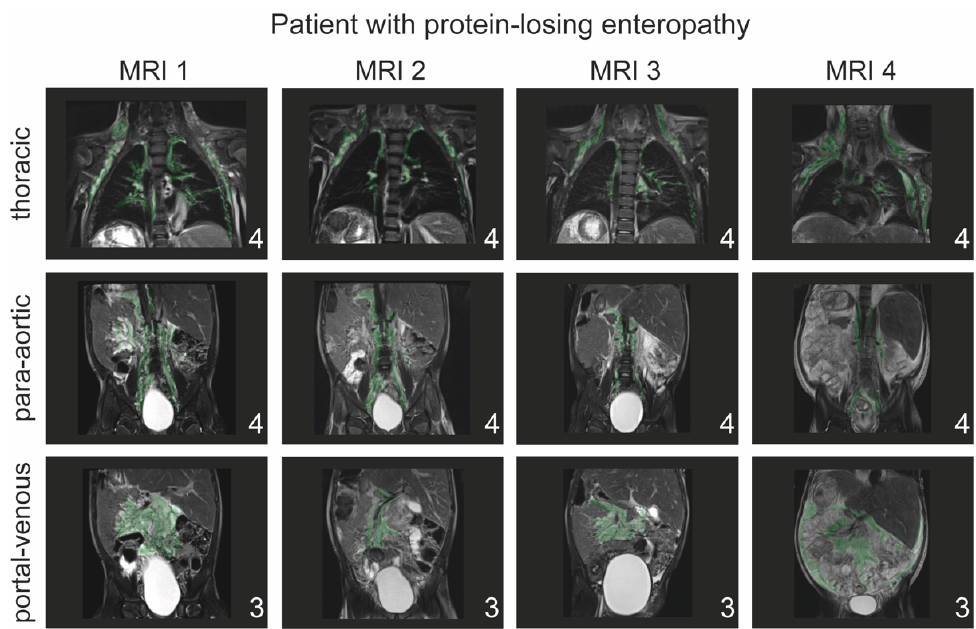
Figure 5. Example of patient with protein-losing enteropathy. Patient who presented with pro- longed pleural effusion (28 days) and edema after TCPC requiring diuretic therapy. Over the next two years, the patient presented with continuous clinical deterioration requiring frequent admis- sions to hospital for volume overload, recurrent pleural effusion, diarrhea and protein loss. The patient underwent serial cardiac MRI and cardiac catheter studies targeting hemodynamic param- eters. Despite clinical variation in the presentation, lymphatic classification did not change during the entire period. A lymphatic fistula to the left lower lobe bronchus and thoracic cavity can be visualized at MRI 1 and remains visible at all four MRIs. At the time of MRI 4 the patient presented with clinical deterioration and a pleural effusion on the left side and ascites in addition to the same degree of lymphatic abnormalities. Lymphatic abnormalities are highlighted in